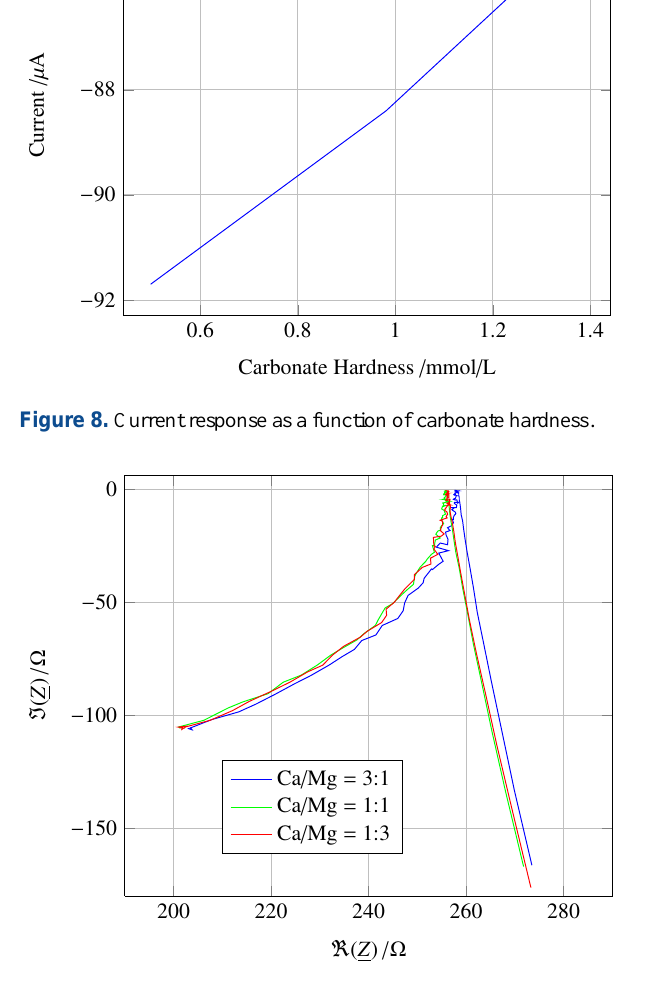
Figure 9. Impedance spectra of water samples with the same total and carbonate hardness but different Ca/Mg ratio (mmolL − 1 ).